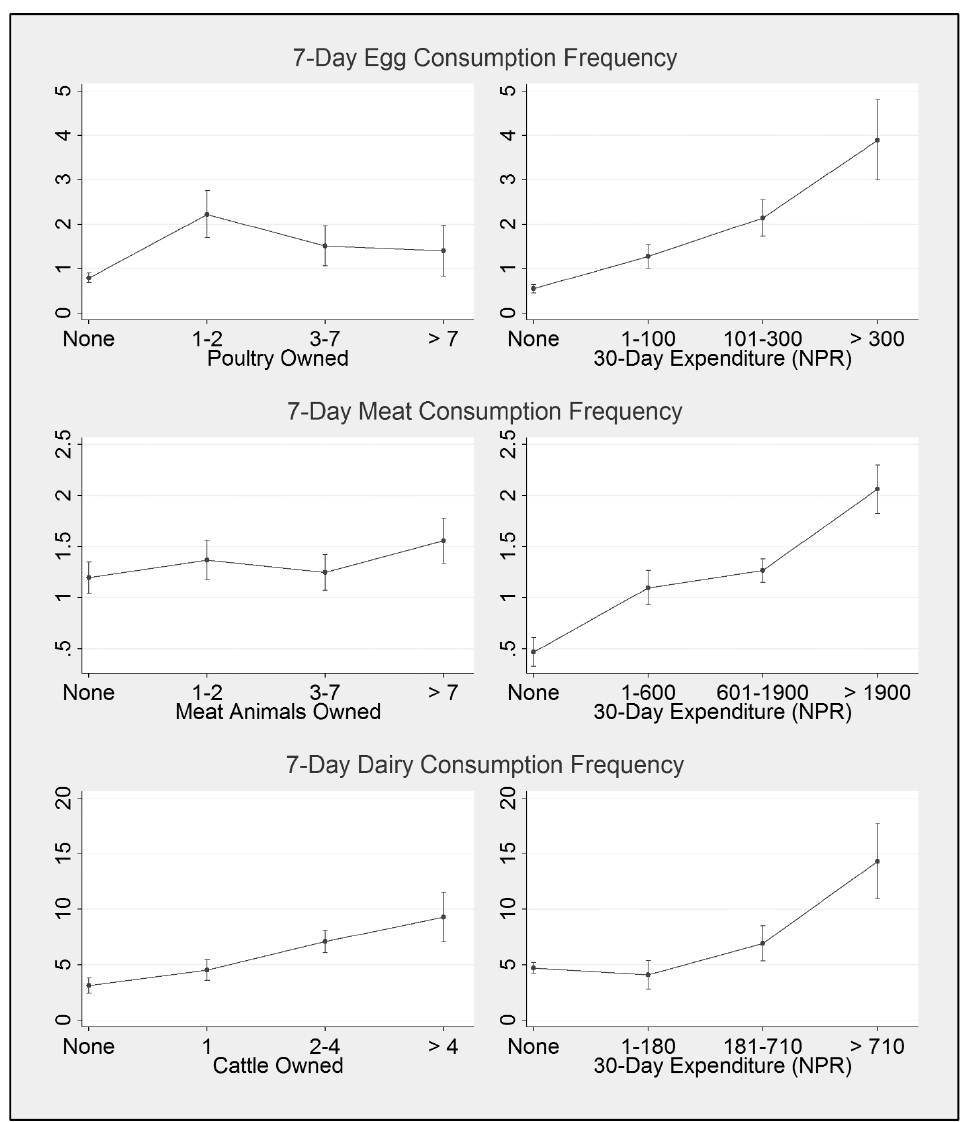
Figure 1. Predicted average weekly consumption frequency (with 95% confidence intervals) of eggs, meat, and dairy at different levels of animal production and expenditure on animal-source foods, adjusting for all other covariates (mother’s education, caste/ethnicity, region, season, child sex, child age). Predictions were generated using negative binomial model estimates presented in Table 2.